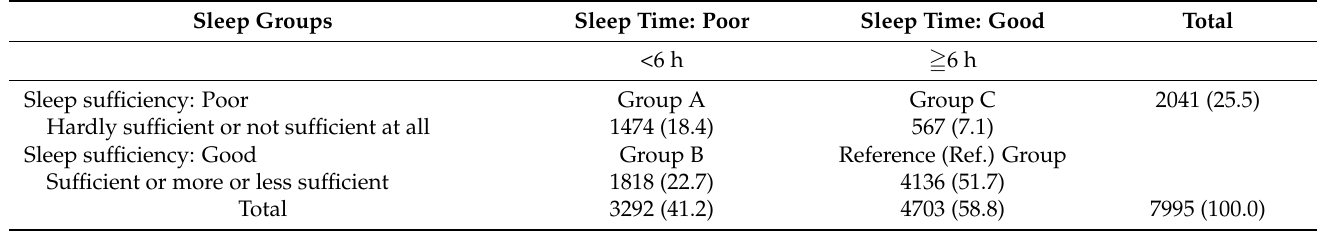
Table 1. Division into groups by sleep time and sleep sufficiency.